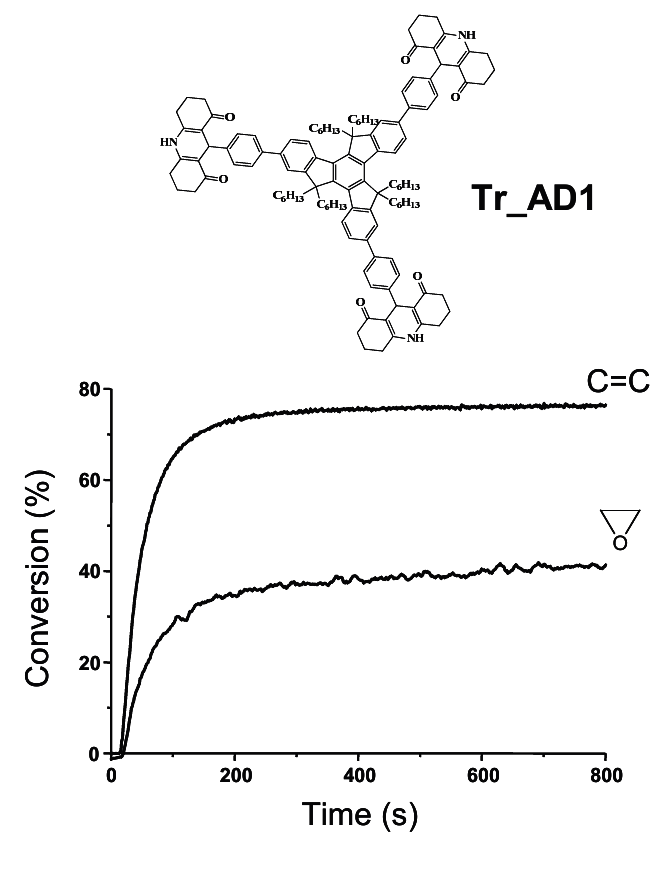
Figure 4. Conversions of the acrylate double bond and the epoxide during the photopolymerization of a TMPTA/EPOX blend (50%/50%) in laminate upon a halogen lamp irradiation in the presence of Tr_AD1/DPI initiating system (0.5%/3% w / w